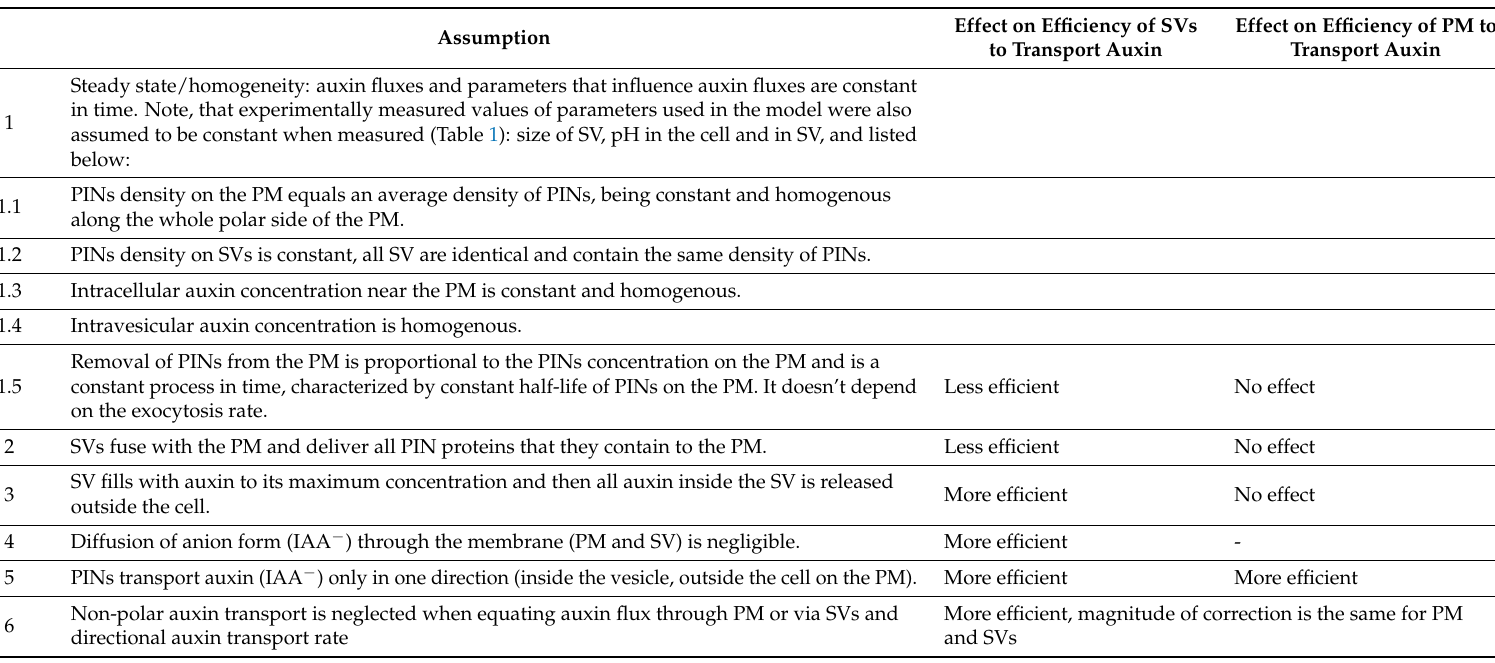
Table 2. List of assumptions